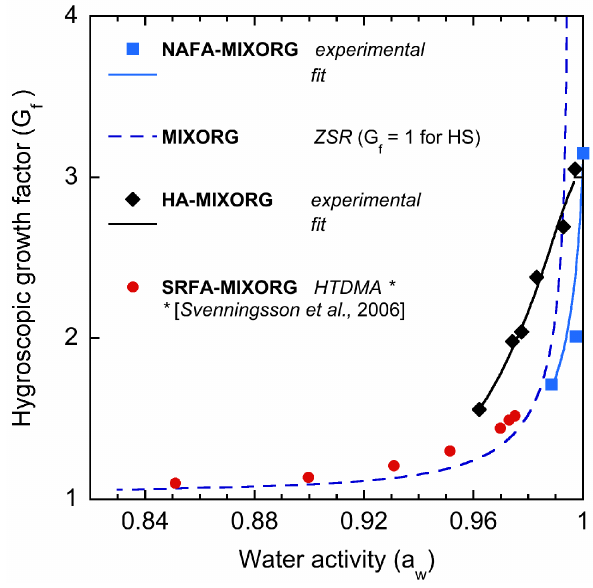
Fig. 8. Hygroscopic growth factor as a function of water activity for NAFA and HA in MIXORG at 25 ◦ C. Solid symbols show growth factors calculated from bulk solution measurements using Eq. (3). Solid lines represent the fit to the data based on the water activ- ity parameterizations presented in Table 1. Red solid circles show HTDMA data at 21–24 ◦ C for Suwannee River fulvic acid (SRFA) in MIXORG from published work by Svenningsson et al. (2004). The dashed line denotes the prediction by the ZSR approach for MIXORG containing NAFA, HA or SRFA, based on no hygro- scopic growth observed for these HS below a w of 0.999 in Zamora et al.